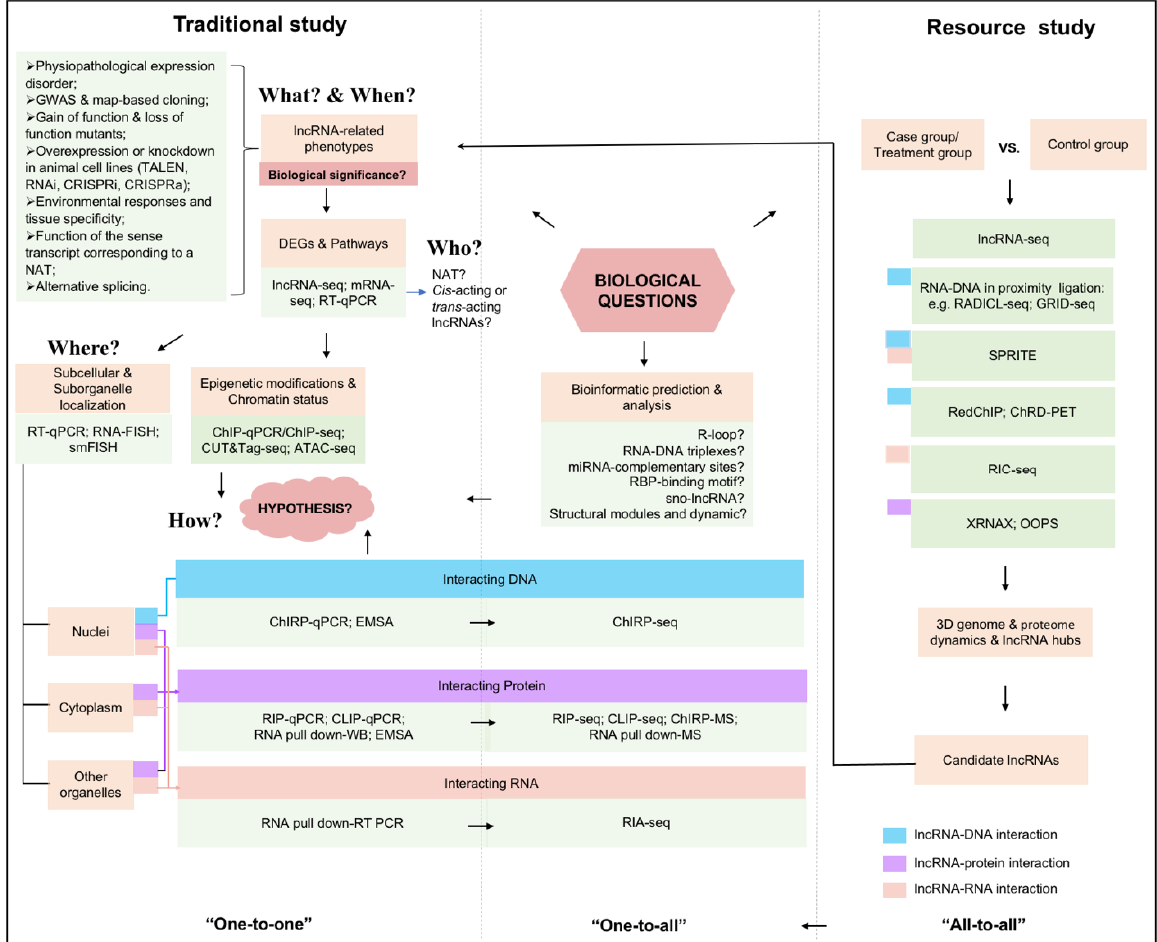
Figure 4. Schematic diagram summarizing the approaches used for lncRNA study. Traditional study of lncRNA include an understanding of ‘when’ a particular lncRNA is transcribed, ‘what’ phenotypes